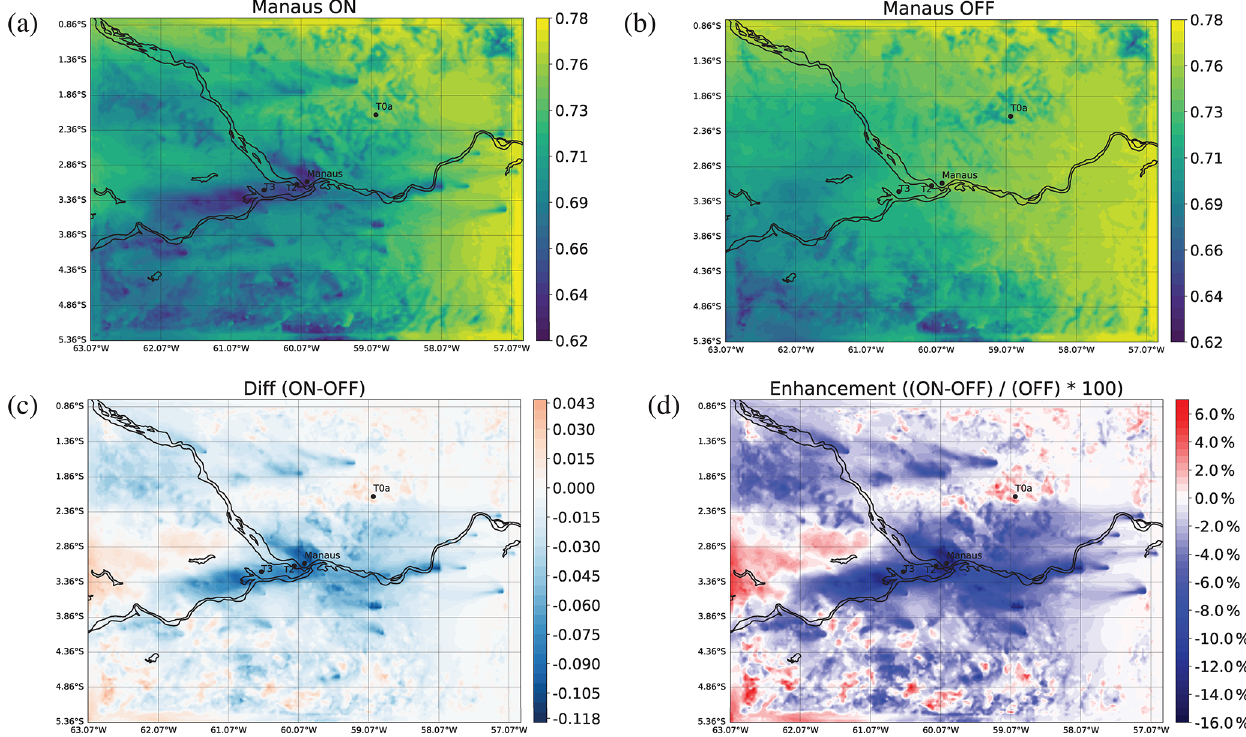
Figure 9. WRF-Chem simulated values of 600nm asymmetry parameter ( g aer ) in the presence or absence of Manaus emissions. (a) g aer , when all emissions are on. (b) g aer , when just biogenic emissions are on and anthropogenic emissions are off. (c) g aer difference between the two simulations, with anthropogenic emissions turned on and off, i.e., ON − OFF. (d) g aer (percent) enhancement calculated from the two simulations, when anthropogenic emissions turned on and off, i.e., ((ON − OFF) / OFF) × 100. WRF-Chem predictions are at ca. 8m altitude, averaged over 13 March 2014